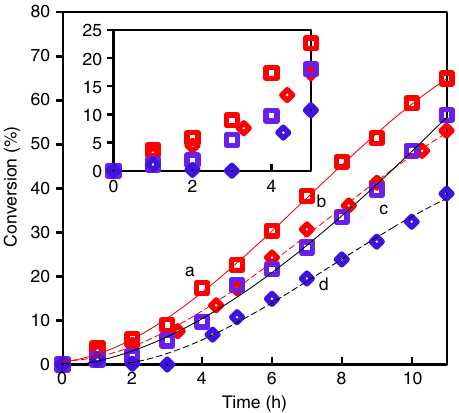
Figure 2 | Effect of triphenylphosphine on reaction rates. Effect of triphenylphosphine (PPh 3 ) addition on the initial rates of COE oxidation. Curves a,b: fivefold diluted filtrates obtained from COE oxidation using Au-SiO 2 -A; Au ¼ 20ngml (cid:2) 1 and hydroperoxide ¼ 0.29mmoles. Curve a: filtrate, b: filtrate þ 0.30mmoles PPh 3 . Curves c,d: fivefold diluted filtrates obtained from COE oxidation using t -BuOOH as reaction initiator. c: filtrate and d: filtrate þ 0.62mmoles PPh 3 . Inset uses the same symbols.